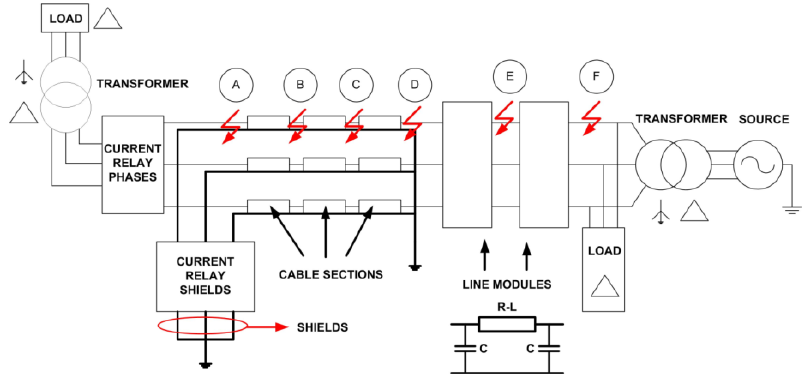
Figure 16. Ground fault positions: schematic representation.